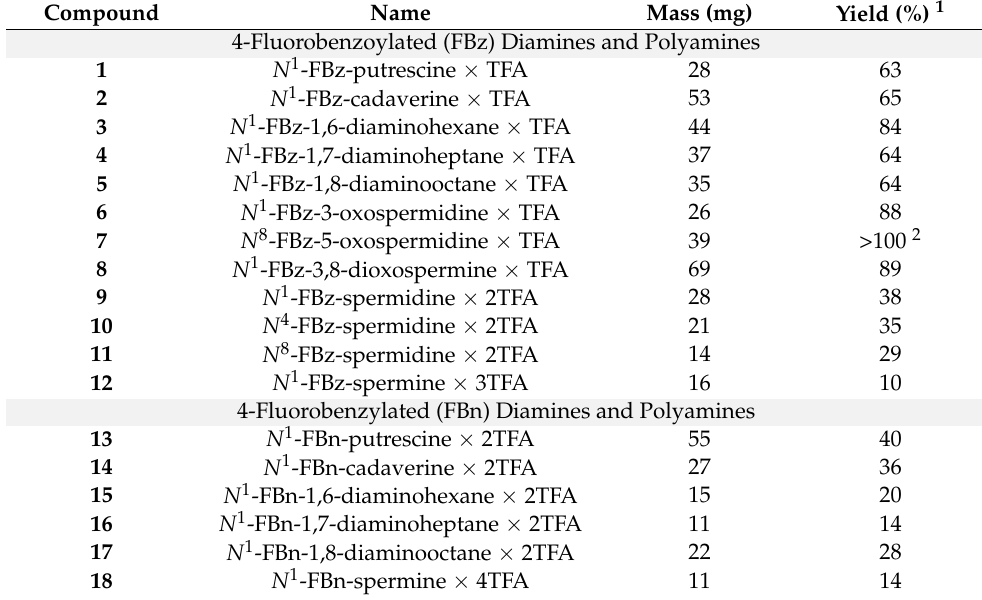
Table 1. Amounts and yields of the purified polyamine derivatives 1 – 18 .